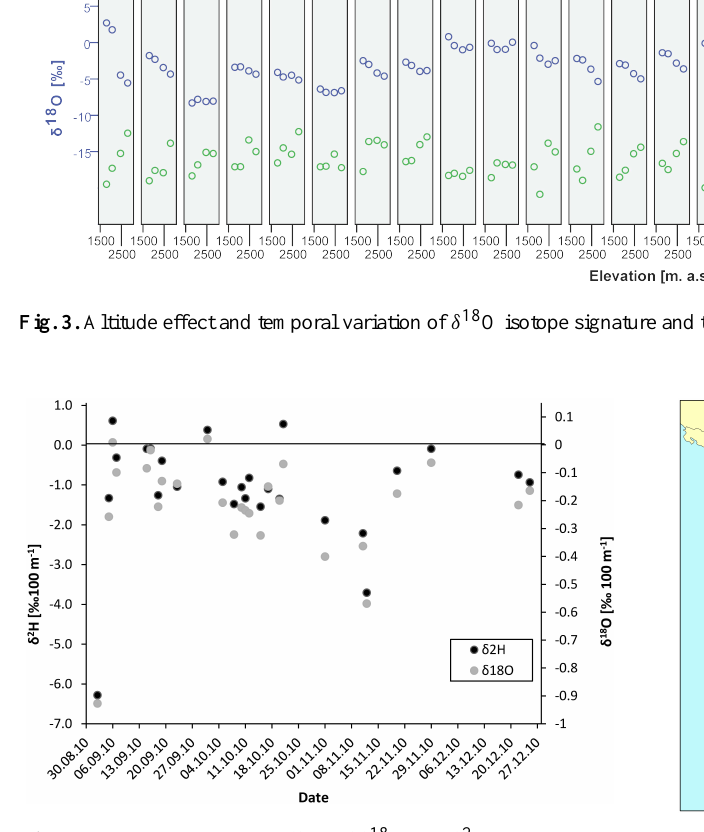
Fig. 5. 12 days back trajectories for the 26 rain events calculated with the Hybrid Single-Particle Lagrangian Integrated Trajectory (HYSPLIT) model developed by Draxler and Rolph